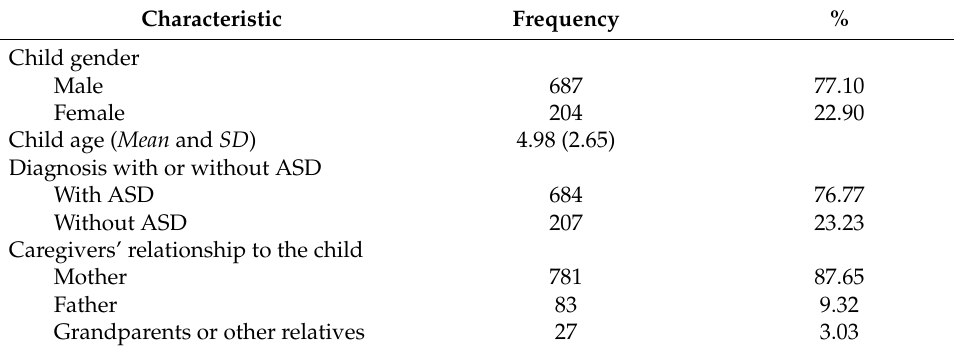
Table 1. Demographic